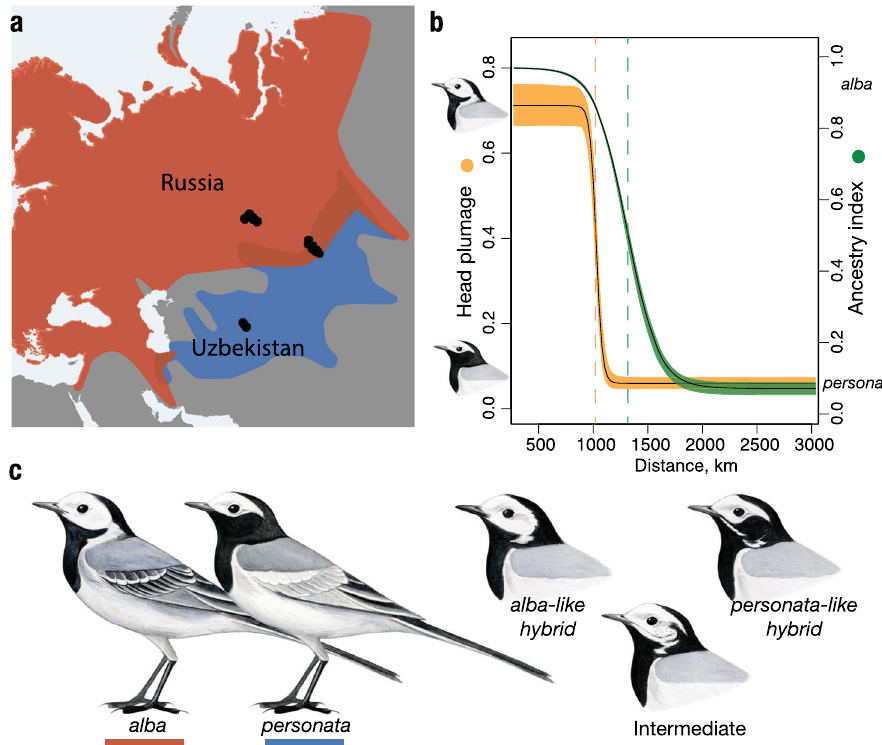
Fig. 1 Distribution of alb a and personata subspecies of the white wagtail and their hybridization patterns. a Geographic distribution and sampling localities used in the present study (black dots). Areas of red ( alba ) and blue ( personata ) color overlap are their hybrid zones. b Geographic clines in head plumage coloration (orange) and genetic ancestry (green) for a 3000 km transect across the alba and personata hybrid zone in central Siberia (redrawn from ref. 16 ). Dashed lines show cline centers, shading is a 95% CI. c Plumage differences between alba and personata , and intermediate variants of head plumage observed in their hybrid zone. The allopatric alba and personata samples originate from terminal parts of the transect in Russia and Uzbekistan, respectively. The individuals we refer to as sympatric alba and personata and all intermediate head plumage phenotypes, were sampled in the area of range overlap (see Supplementary Table 1 for sampling details). Drawings are courtesy of Jillian